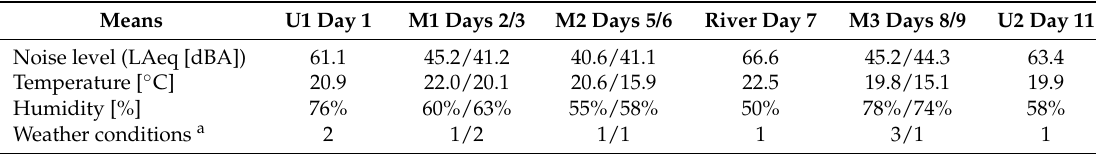
Table 2. Environmental data per study site and